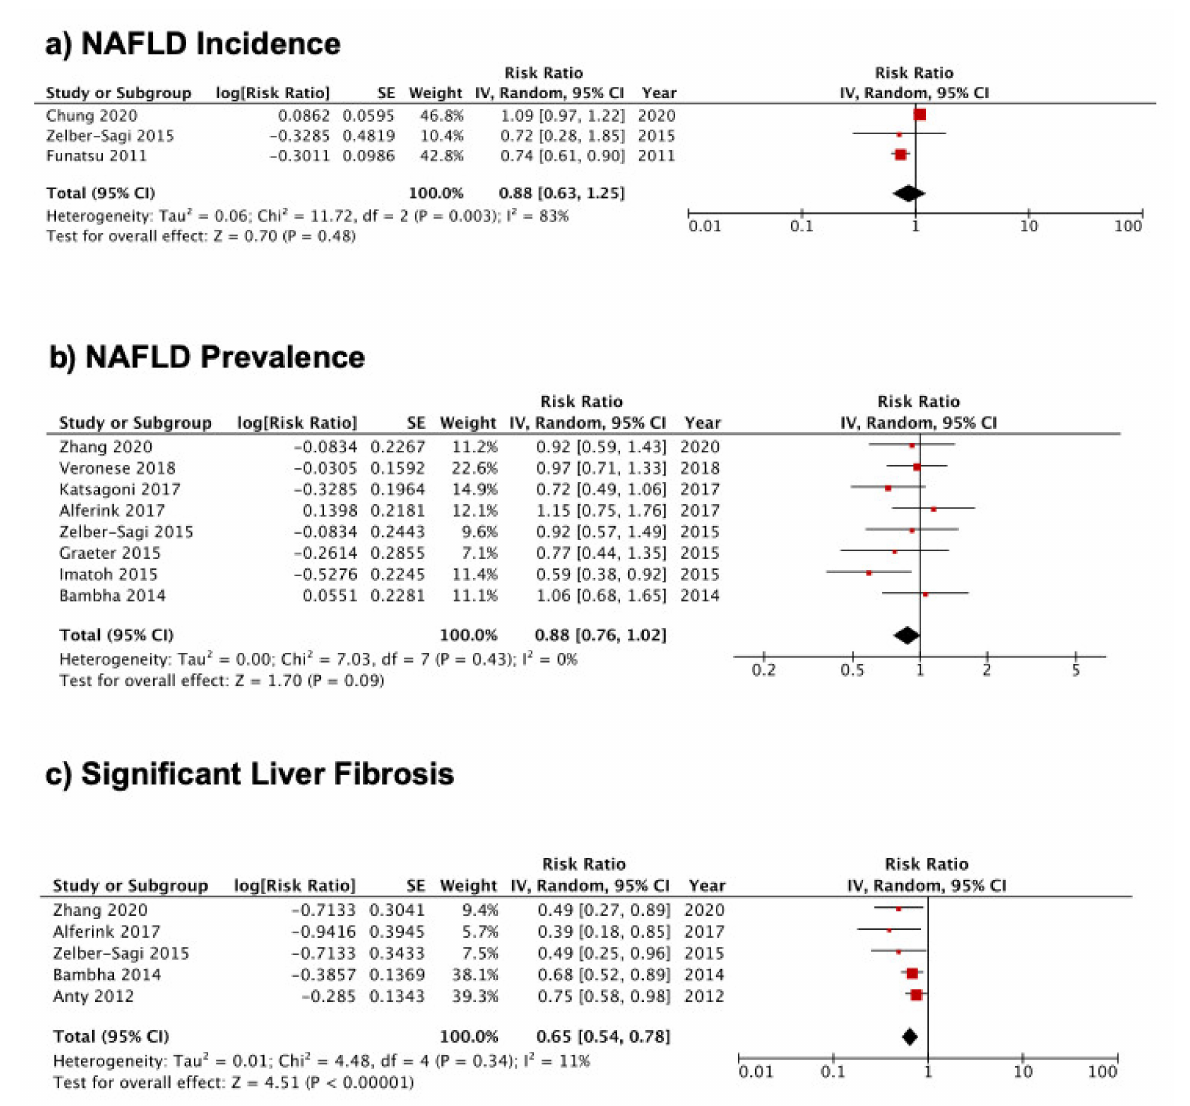
Figure 2. Forest plot for the association between coffee consumption and ( a ) NAFLD incidence, ( b ) NAFLD prevalence, and ( c ) significant liver fibrosis. Relative risk for the highest versus the lowest level of coffee consumption was pooled using random-effects